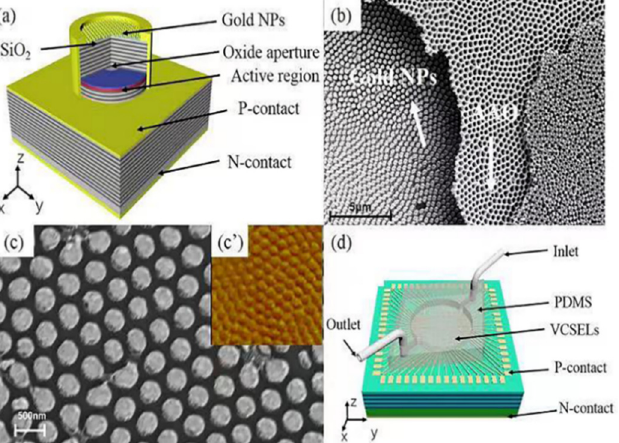
Figure 1. ( a ) Schematic diagram of VCSEL integrated with gold particles. ( b ) SEM of gold particles with a part of AAO film. ( c ) SEM diagrams of gold particles. ( c’ ) AFM diagrams of gold particles. ( d ) Schematic diagram of the refractive index sensor chip with a microfluidic channel.